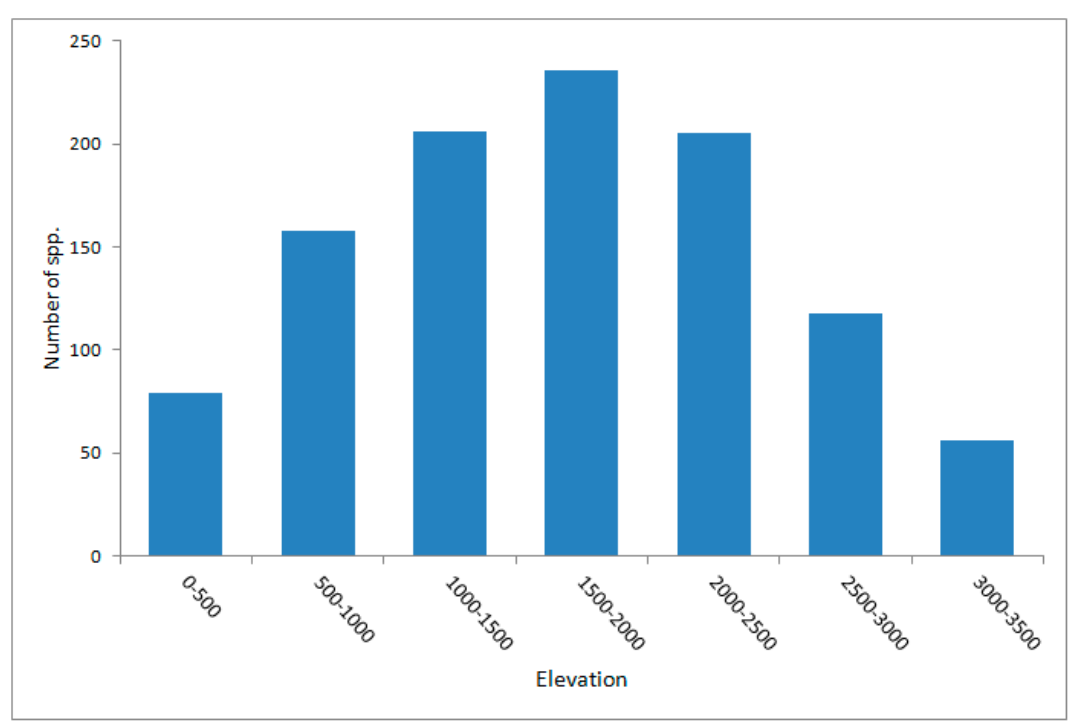
Figure 4. Elevational distribution of the pteridoflora in the SMOc.